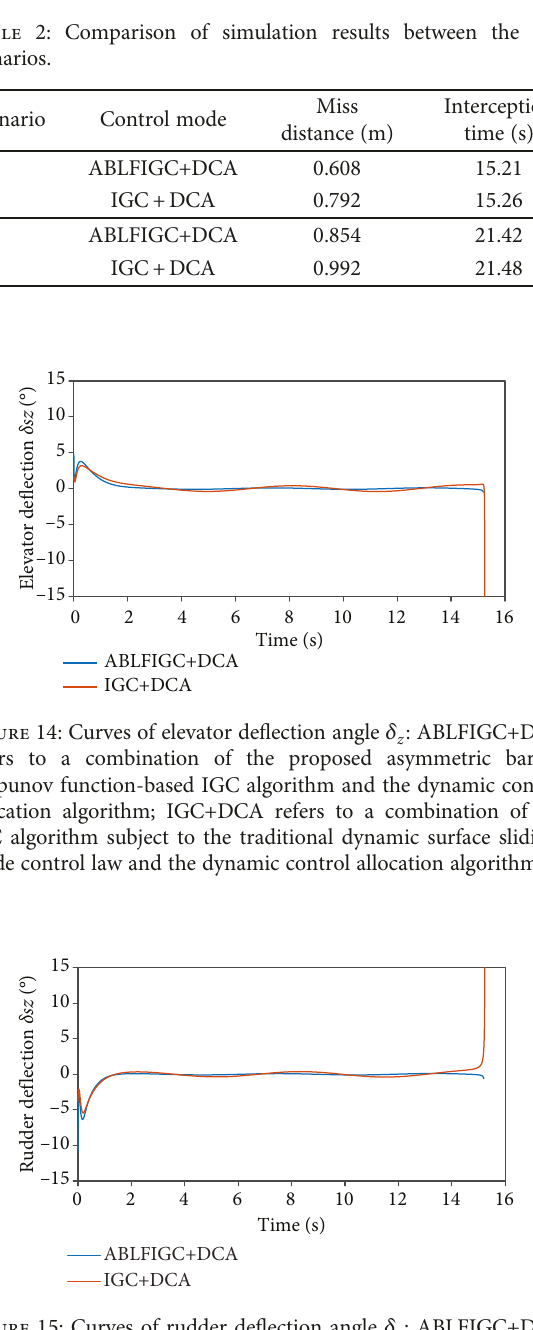
Figure 15: Curves of rudder de fl ection angle δ : ABLFIGC+DCA y refers to a combination of the proposed asymmetric barrier Lyapunov function-based IGC algorithm and the dynamic control allocation algorithm; IGC+DCA refers to a combination of the IGC algorithm subject to the traditional dynamic surface sliding- mode control law and the dynamic control allocation algorithm.